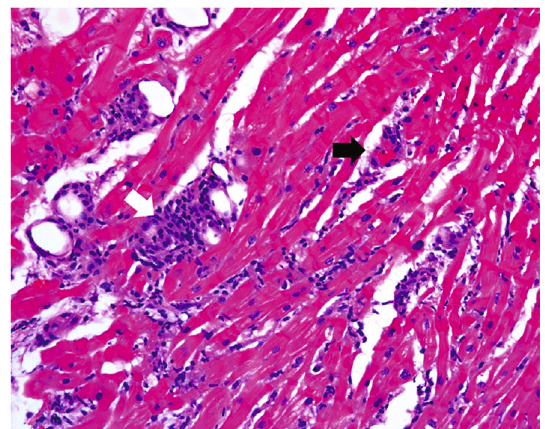
Figure 2: Close up image showing cardiac myocytes surrounded by dense collections of in fl ammatory cells (white arrow) and focal capillaritis (black arrow), consistent with grade 2R (borderline 3R) rejection.